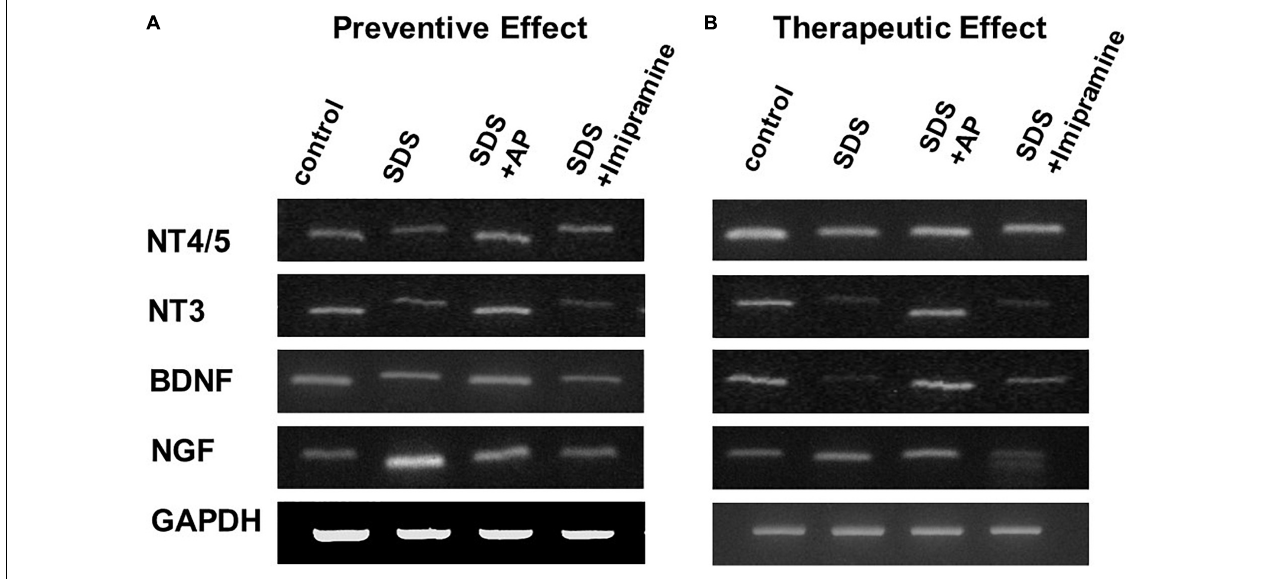
FIGURE 6 | mRNA expressions of neurotrophic factors in the brain of SDS mice. (A) mRNA expressions of neurotrophic factors in the brain of SDS mice with ongoing symptoms of depression. (B) mRNA expressions of neurotrophic factors in the brain after treatment of depression in SDS mice. AP, acupuncture; BDNF, brain-derived neurotrophic factor; GAPDH, glyceraldehyde 3-phosphate dehydrogenase; NGF, nerve growth factor; NT, neurotrophin; SD, standard deviation; SDS, social defeat stress.